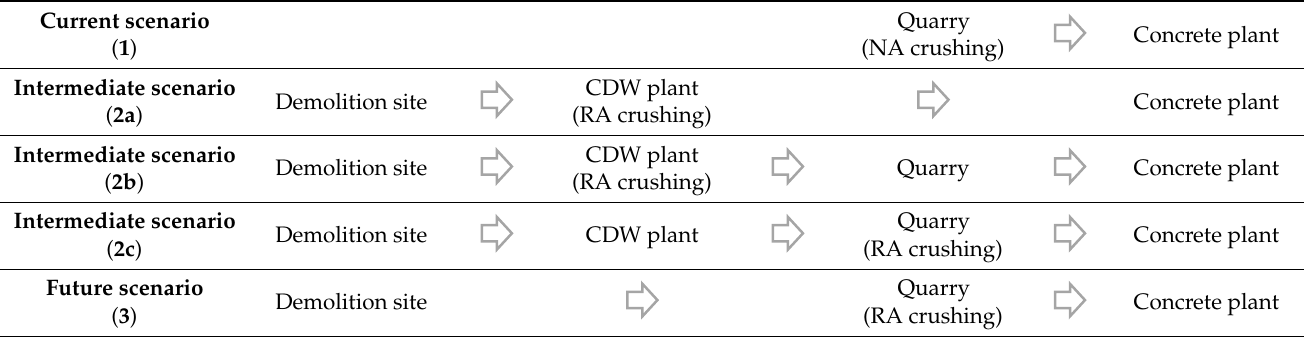
Table 3. EI for the production and transport of NAs and RAs.